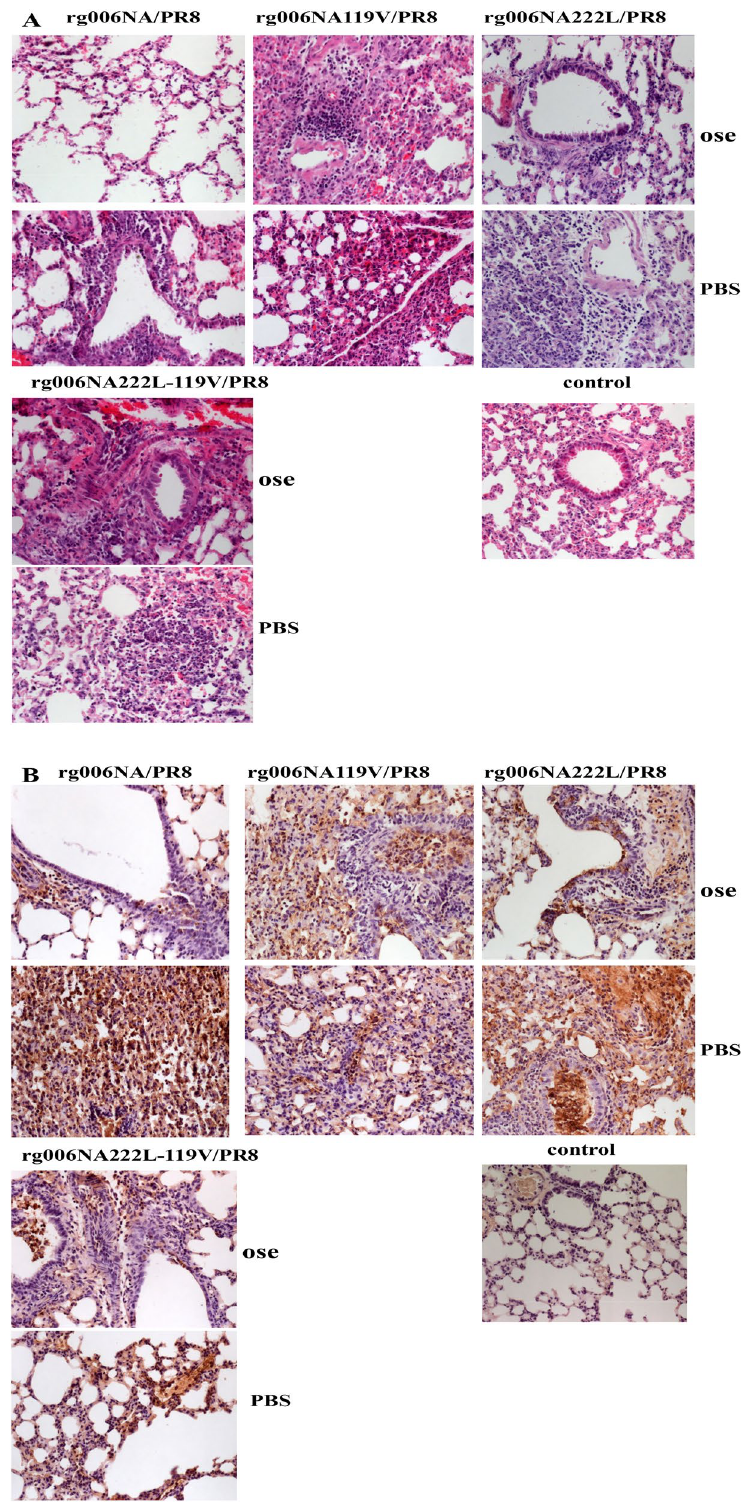
Figure 7. Pathological changes of lung tissue of mice infected with H7N9/PR8 recombinant viruses treated with oseltamivir phosphate. The lung tissues of mice infected with H7N9/PR8 recombinant viruses were stained by hematoxylin and eosin (( A ) HE × 20) and NP antigen (( B ) IHC × 20) 4 days after infection. Ose (oseltamivir treatment group): 2MLD 50 rg006NA/PR8, 20 mg/kg/day, rg006NA119V/PR8, rg006NA222L/PR8 or rg006NA222L-119V/PR8 infection, oseltamivir phosphate by gavage from 0 to 4 dpi; PBS(control group): 2MLD 50 rg006NA/PR8, 20 mg/kg/day, rg006NA119V/PR8, rg006NA222L-119V/PR8 or rg006NA222L/PR8 infection, PBS by gavage from 0 to 4 dpi. Control group, PBS, 20 mg/kg/day oseltamivir phosphate by gavage from 0 to